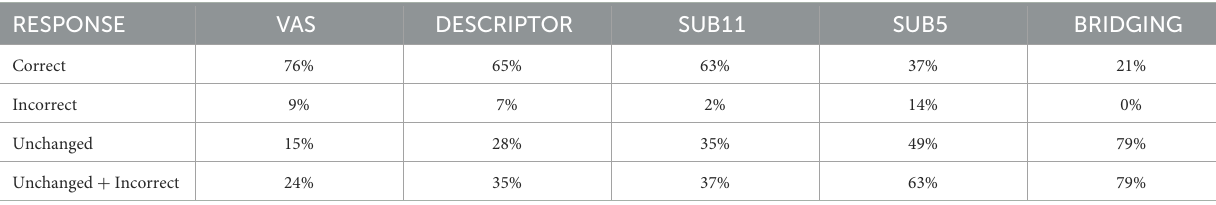
TABLE 1 Responses for 5 different scoring systems comparing healing of TPLO osteotomy.